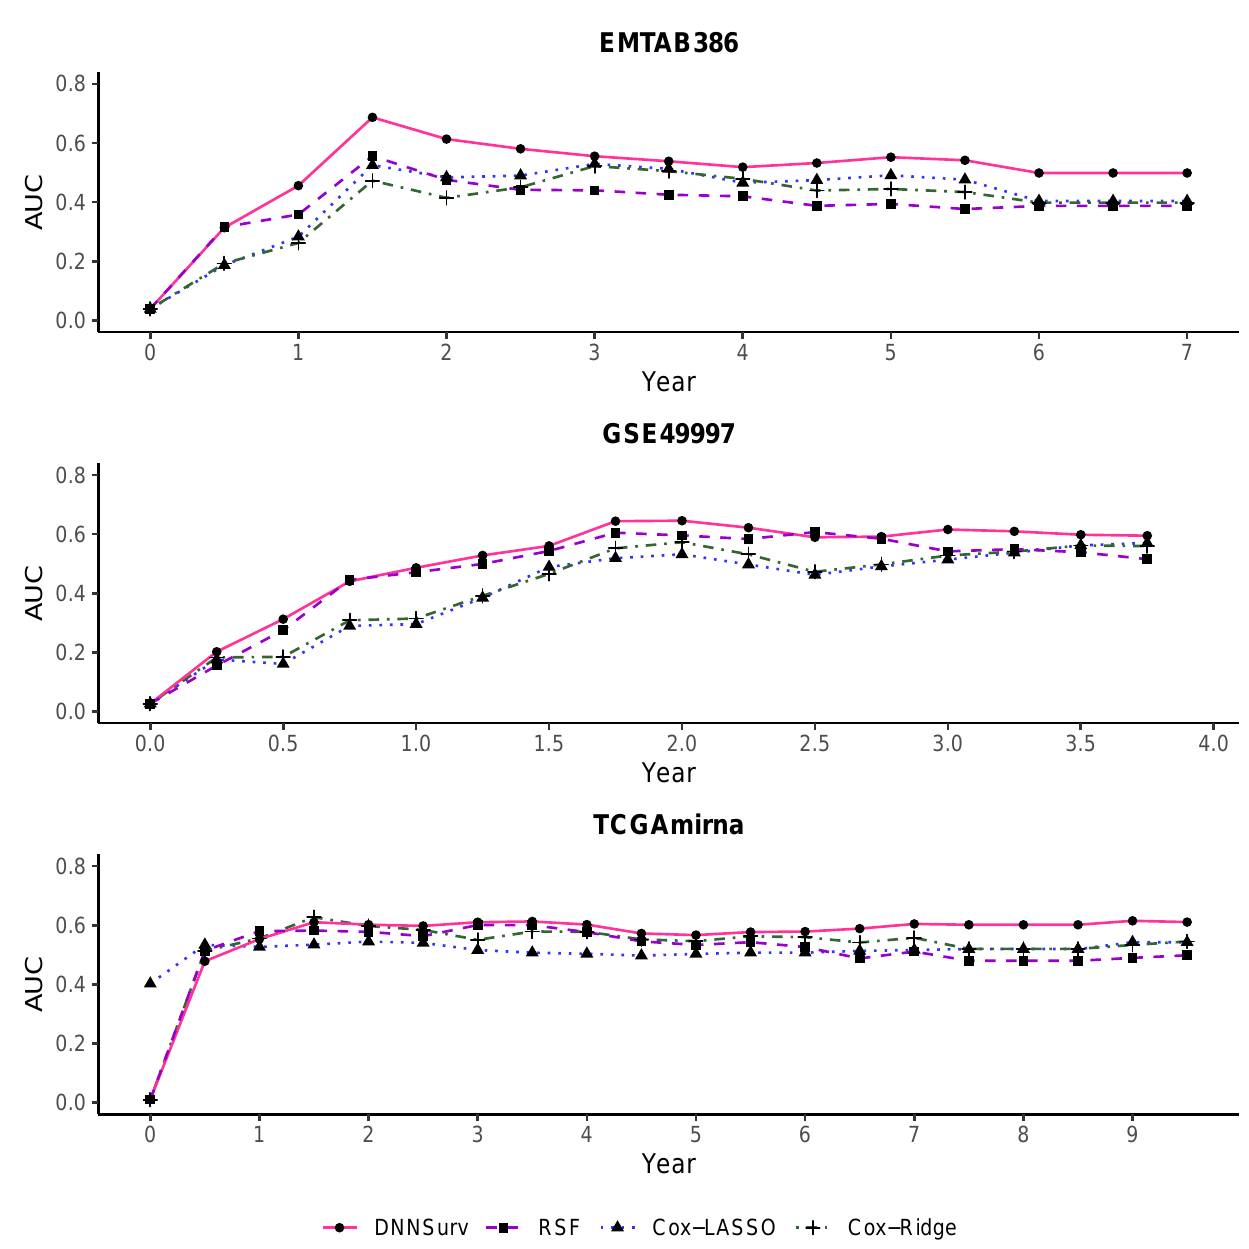
Figure 8. The time-dependent AUC for all four models on three test datasets that contain gene features only (G).